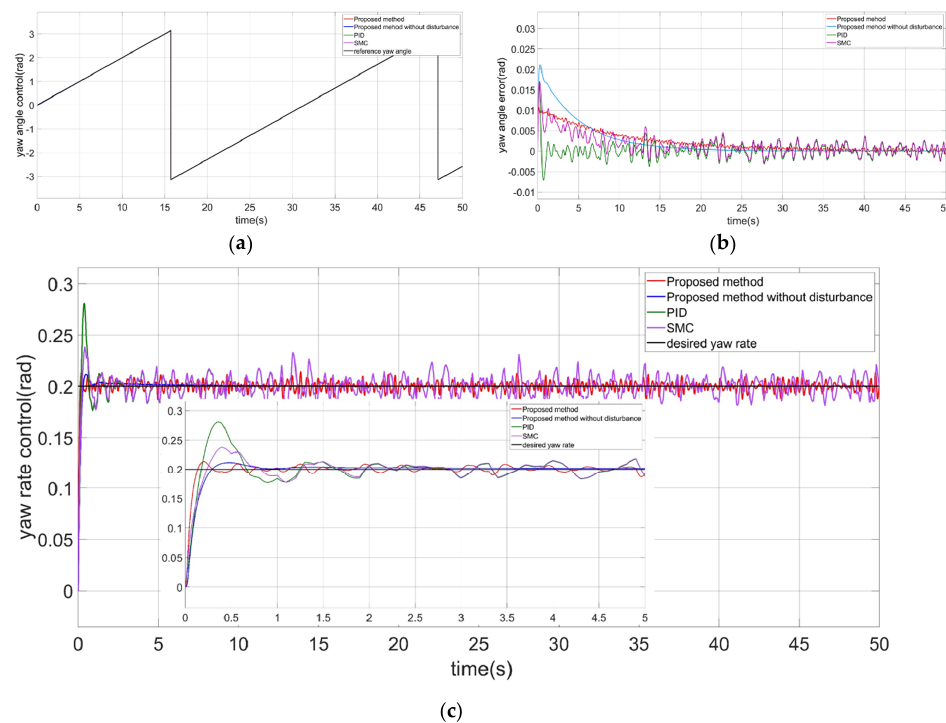
Figure 21. The control results of the yaw angle and yaw angular velocity control. ( a ) The control results of the yaw angle. ( b ) The tracking error of the yaw angle. ( c ) The control results of the yaw angular velocity.